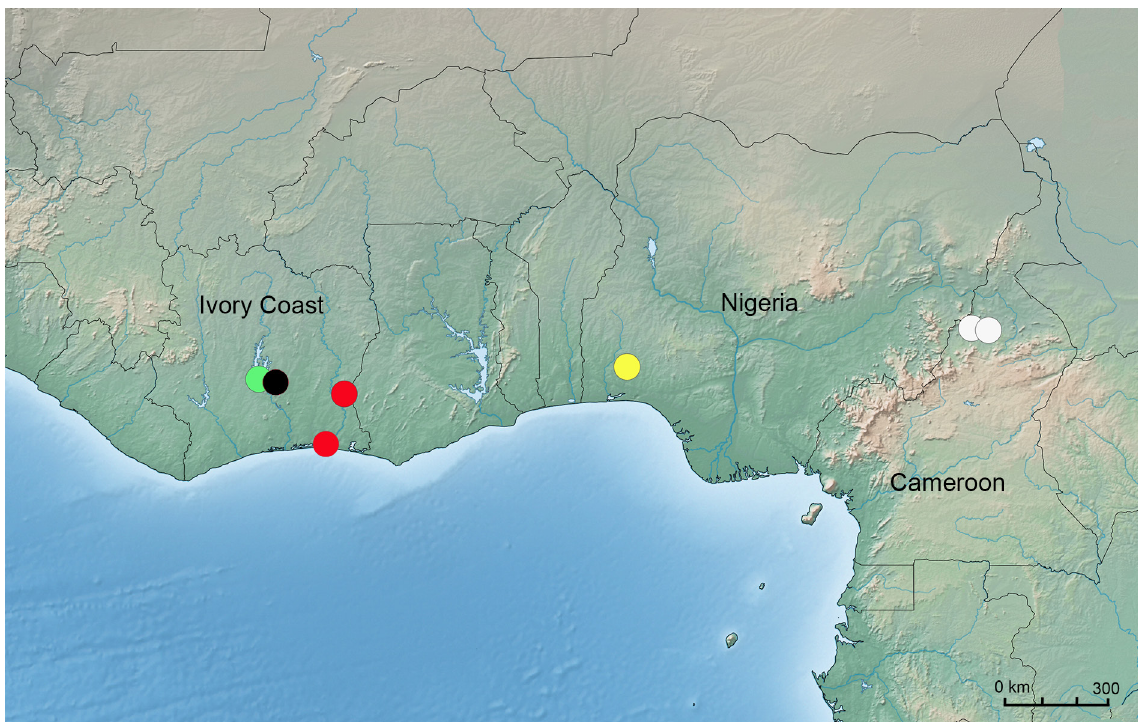
Fig. 39. Distribution map of species of Andromma Simon, 1893. A. albinovani sp. nov. (green), A. delphiurum sp. nov. (yellow), A. elephantactes sp. nov. (red), A. helix sp. nov. (black) and A. prosopion sp.